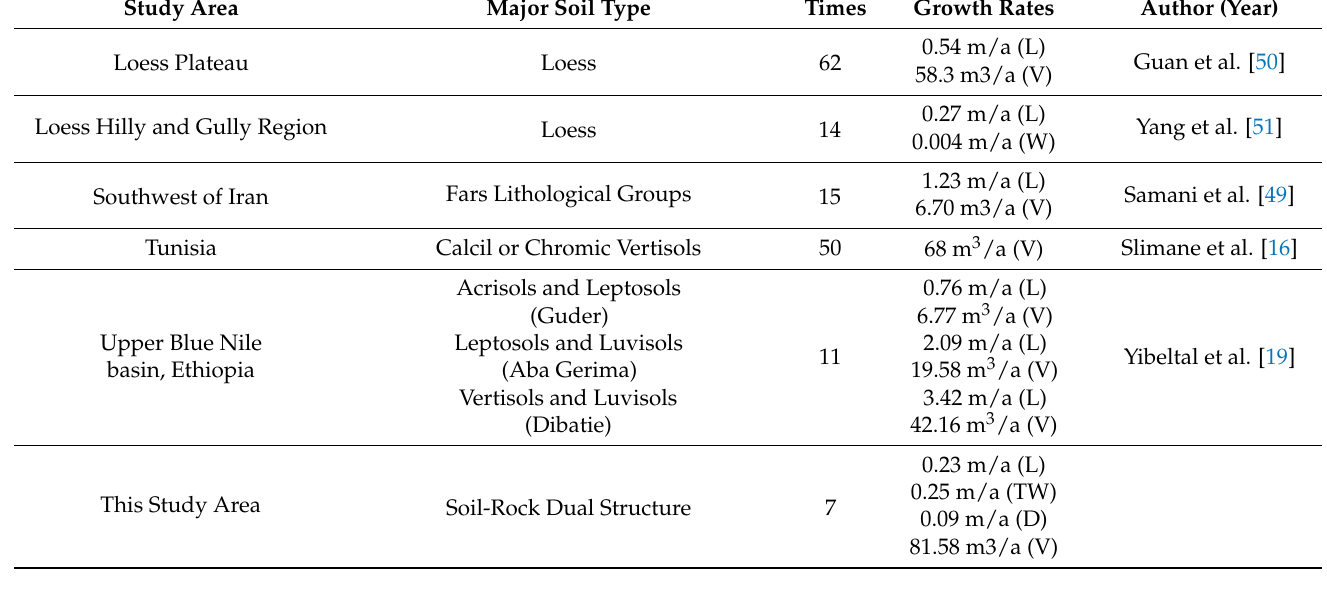
Table 5. Development rates of gully erosion in different erosion areas.